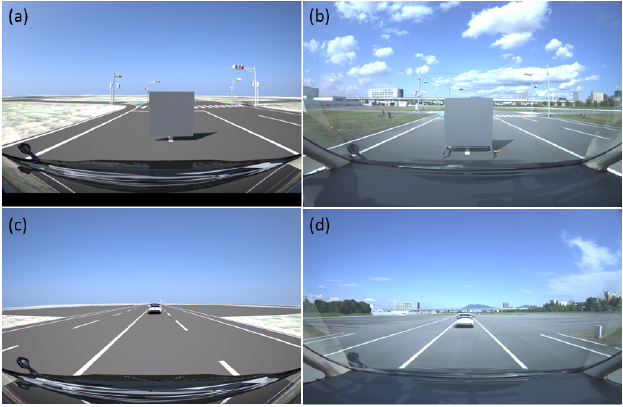
Figure 24. ( a ) Simulated static scene of plate target. ( b ) Static real scene of plate target. ( c ) Simulated static scene of vehicle target. ( d ) Real static scene of vehicle target. The ego vehicle is equipped with LiDAR, camera, and GNSS/INS RT3000 v3 from OxTS as a reference sensor with a range accuracy of 0.01m. The LiDAR sensor was mounted on the vehicle’s roof, and the camera sensor was mounted on the front windscreen. The 10% reflective plate size is 1.5 × 1.5m. The sensor position in the vehicle’s coordinates is x = 2279mm, y = 96mm, and z = 2000mm. The reference distance is measured from the sensor’s reference point to the center of the Lambertian plate and the target vehicle trunk.